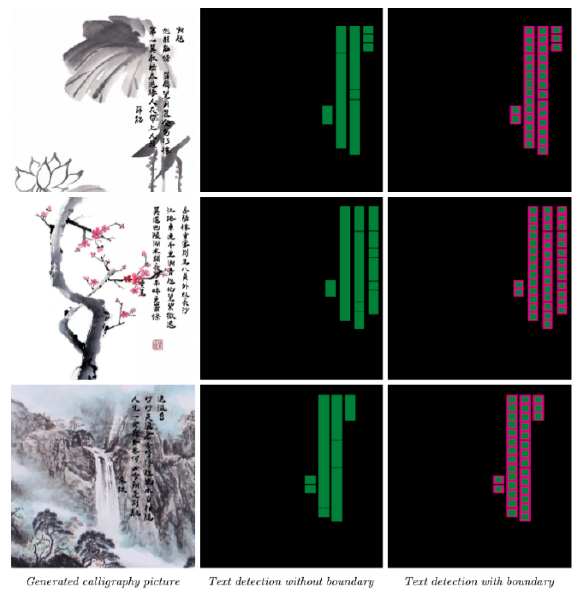
Figure 12. Comparison of pre-training detection feature diagram.